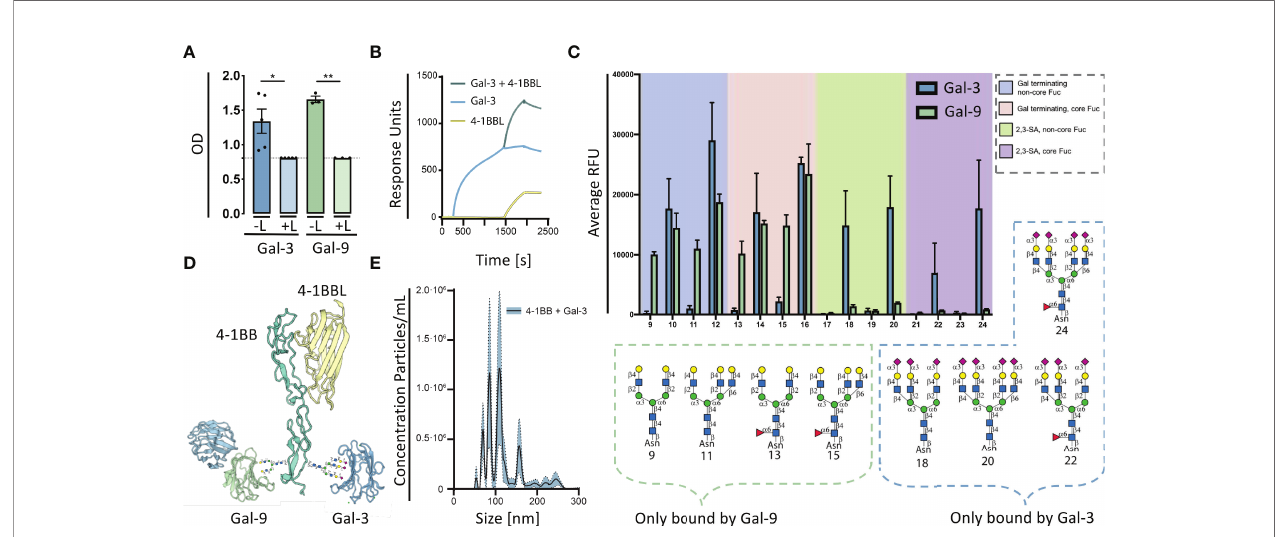
FIGURE 1 | Galectins are capable of glycan dependent binding to 4-1BB. (A) 4-1BB binding to galectin-3 (Blue) or galectin-9 (Green) and with added 0.1 M Beta- lactose (L) measured by ELISA. Data are expressed as mean ± SEM (n=5 and n=3, respectively), Student ’ s paired t-test, *P<0.05, **P<0.01. (B) Surface plasmon resonance analysis of the binding of 4-1BBL (yellow line), Gal-3 (blue line), and co-injection hereof (green line), fl owing along a BIAcore CM5 sensor chip with immobilized 4-1BB : Fc. (C) Glycan microarray analyses of human Galectin-9 using the N-Glycan array, Gal-9, was tested at 50 mg/mL. Binding with glycans 9 to 24 is depicted, the complete set of printed glycans and structural information can be found in Table EV3 . Gal-9 binding is shown by green bars representing the mean and the error bars represent the SD among the values of four replicate spots. Reported Gal-3 binding is marked by blue bars again as mean with SD. The probes are grouped as indicated in the colored panels. Glycan structures bound speci fi cally by Galectin-3 and Galectin-9 are displayed. (D) Proteins were modelled using SWISS-MODEL licensed under the CC BY-SA 4.0 Creative Commons Attribution-ShareAlike 4.0 International License modi fi ed with glycans in the CRD4 part of 4- 1BB. Only the carbohydrate recognition domains of Gal-3 and Gal-9 are shown. (E) Detection of complexes generated by rh4-1BB and rhGal-3 (both 5 m g/ml) measured by nanoparticle tracking analyses. Data expressed in a scatter-mode by 5 recordings of 60s (n=5). Dashed line represents intraassay variation. The curve displayed are the difference between nanoparticle tracking analyses data obtained by rh4-1BB+rhGal-3 subtracted the sum of nanoparticle tracking analyses data obtained by the two individual